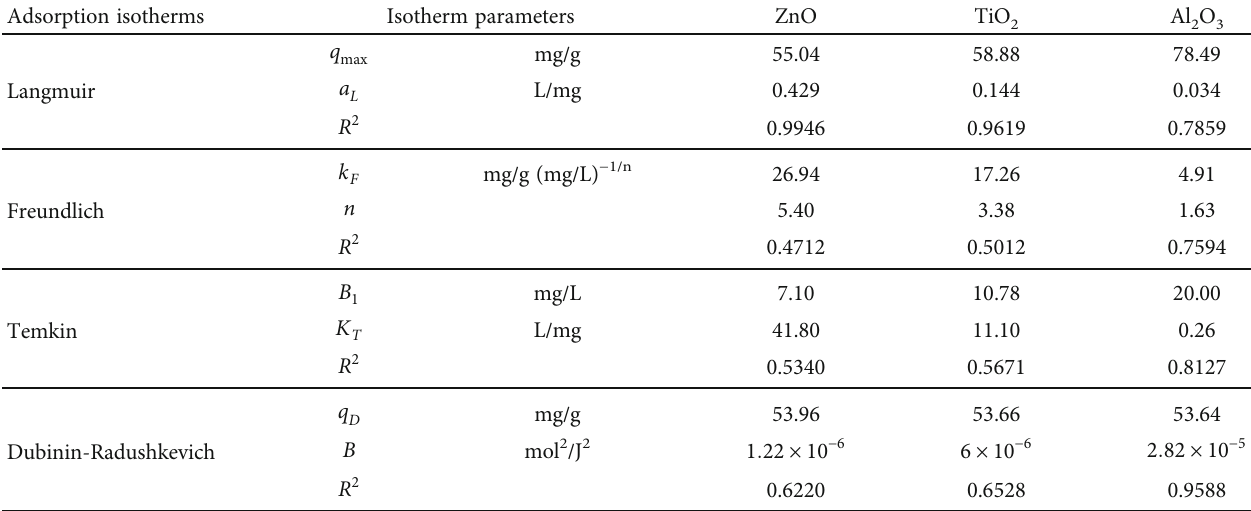
Table 2: Isotherm parameters related to the adsorption of Pb(II) onto adsorbents.